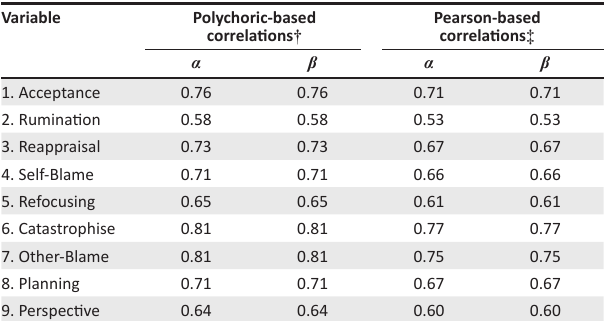
TABLE 2: Reliability estimates for the Cognitive Emotion Regulation Questionnaire- short scales. Variable Polychoric-based correlations †